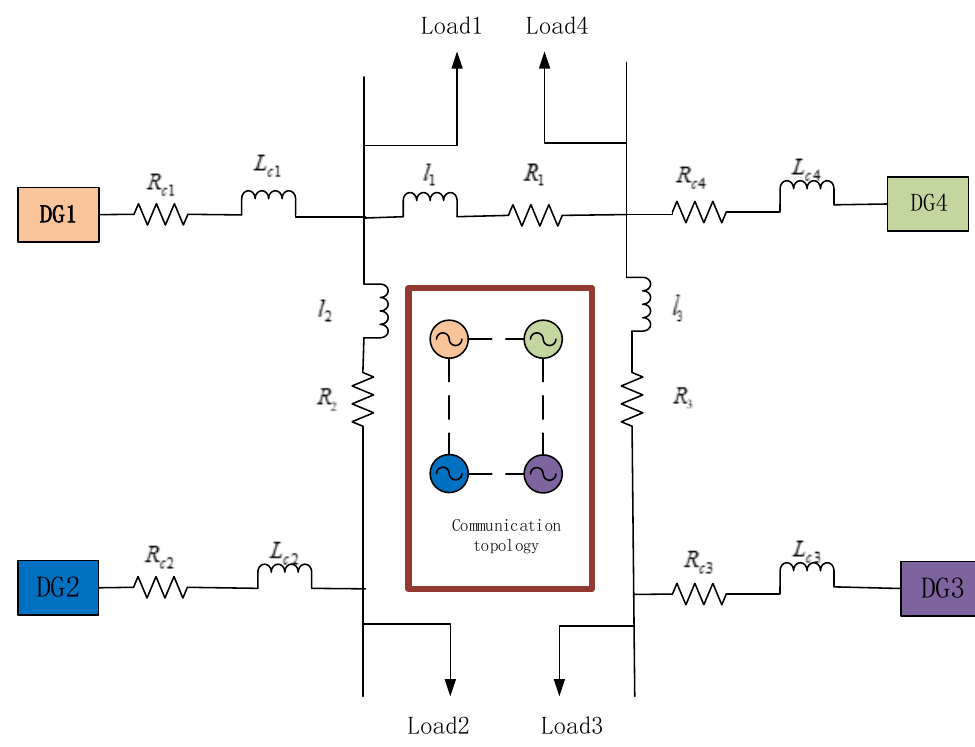
Figure 6. Islanded microgrid with communication topology. Table 2. Circuit parameters of the microgrid.